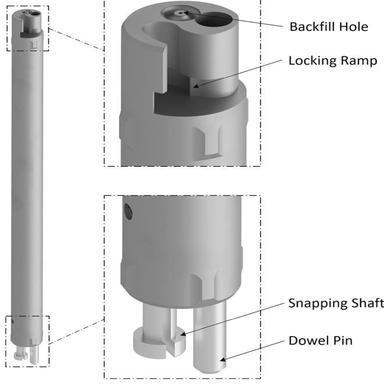
Schematic of the standard capsule locking end caps.